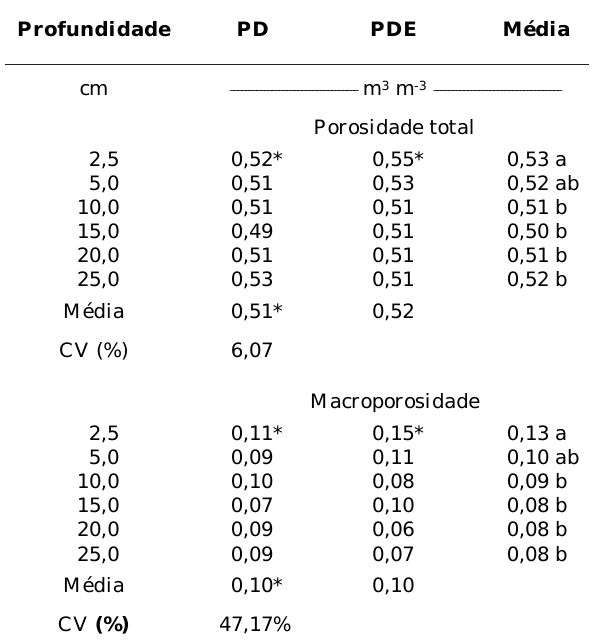
Figura 2. Percentual do solo coberto com restos culturais em diferentes manejos de plantio direto (PD), plantio direto escarificado (PDE) e mecanismos sulcadores: guilhotina (G) e duplo disco (DD).